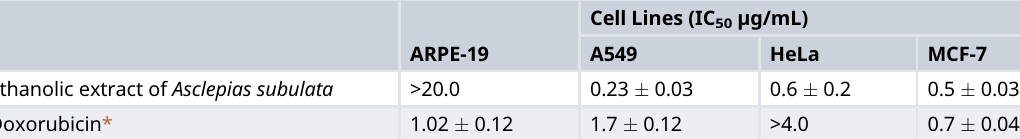
Table 2. Antiproliferative activity of the ethanolic extract of Asclepias subulata.